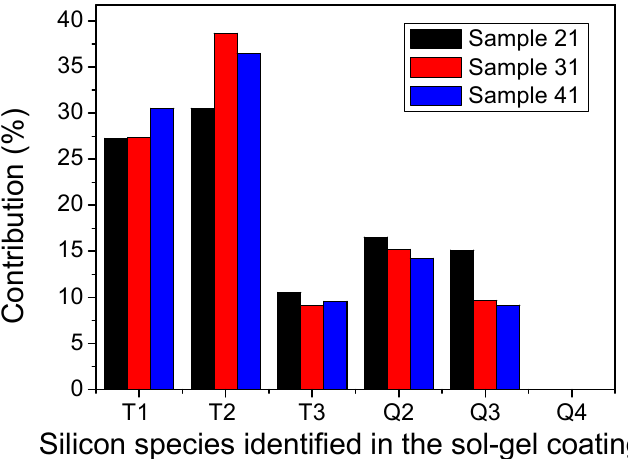
Figure 5. Relative proportion (%) of di ff erent T-type and Q-type silicon units identified by 29 Si-NMR Figure 5 . Relative proportion (%) of different T-type and Q-type silicon units identified by 29 Si-NMR spectroscopy for 21, 31 and 41 samples. spectroscopy for 21, 31 and 41 samples.